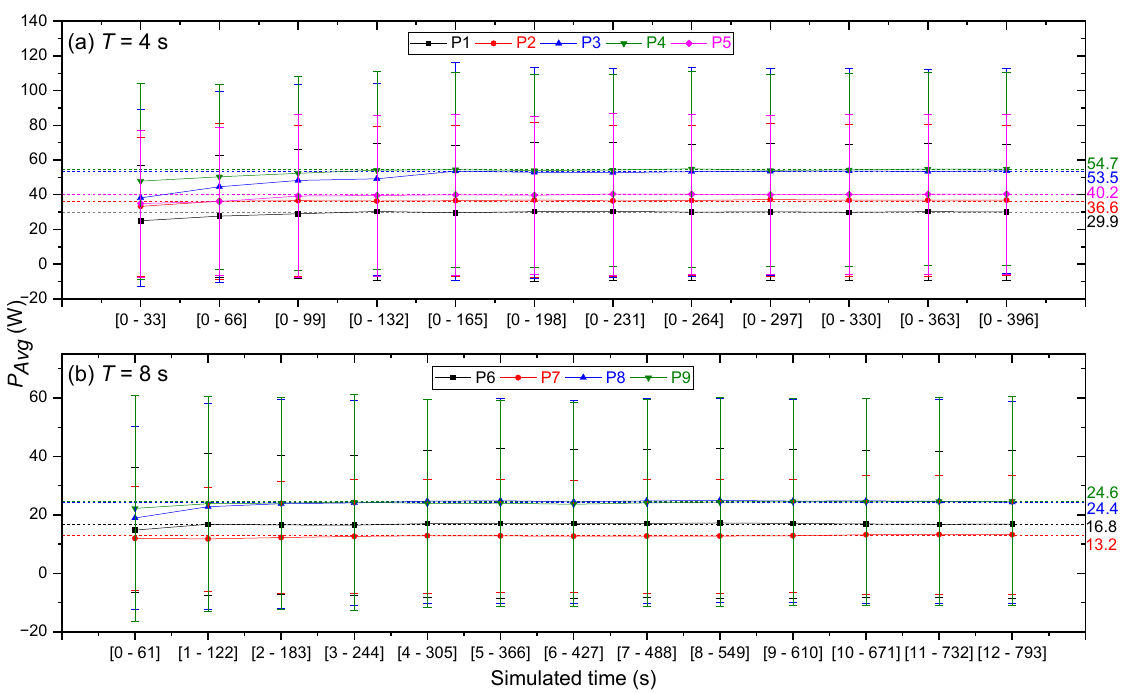
Figure 5. One hundred waves simulated for the buoy with R = 0.25 m: ( a ) for T = 4 s and ( b ) for T = 8 s. Details of P1 to P9 are described later in Section 4.2.